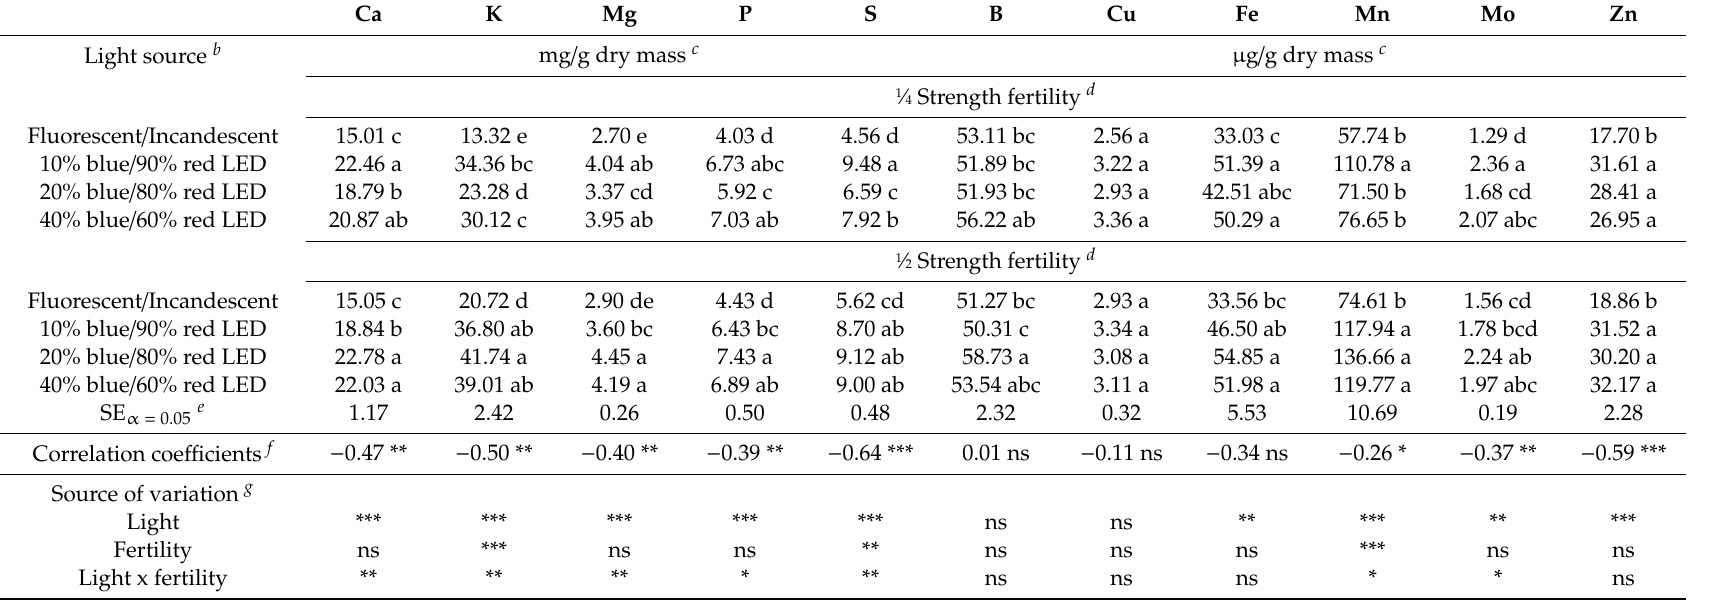
Table 1. The e ff ects of four light quality and two fertility treatments on shoot tissue mineral element concentrations for “Green Lance” Chinese kale ( Brassica oleracea var alboglabra ) grown in controlled environments a